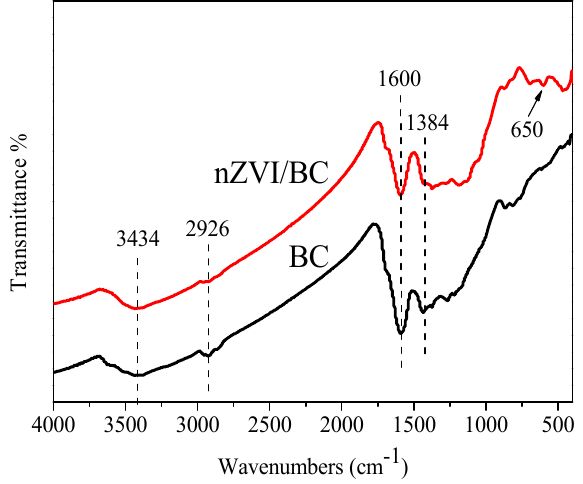
Figure 4. Fourier transform infrared spectroscopy (FT-IR) spectra of BC and nZVI/BC.